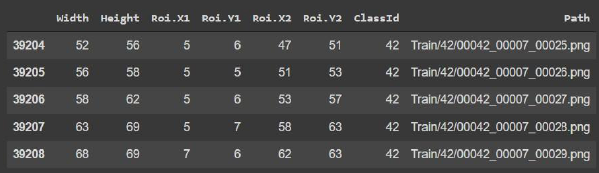
Fig. 5. Head Function on GTSRB Dataset